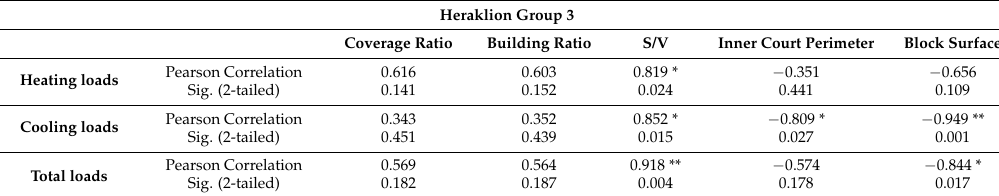
Table 13. Correlation of form parameters to load demand of the urban blocks of group 3 for the climate of